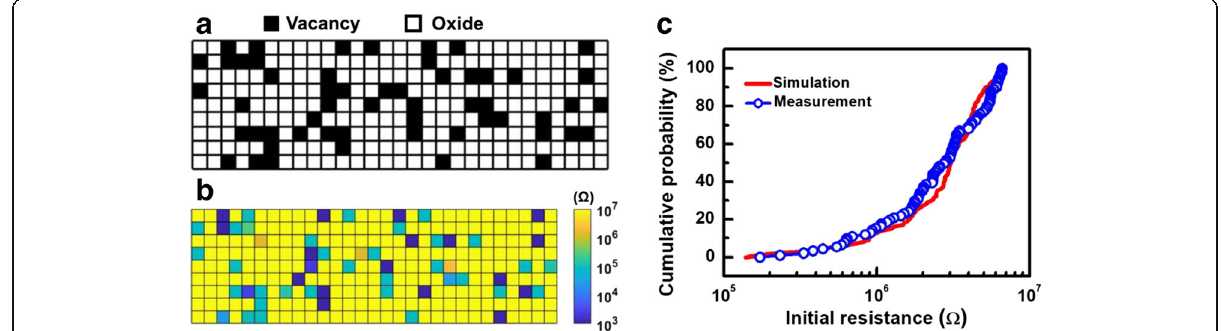
Fig. 5 a Random distribution of intrinsic Vo- is initially given in RRAM film. b Localized resistance distribution of Vo- calculated by trap-assisted tunneling consideration. c R ini distribution of fresh cells collected from CRRAM arrays agrees well with the simulation data by considering TAT conduction mechanism of preforming